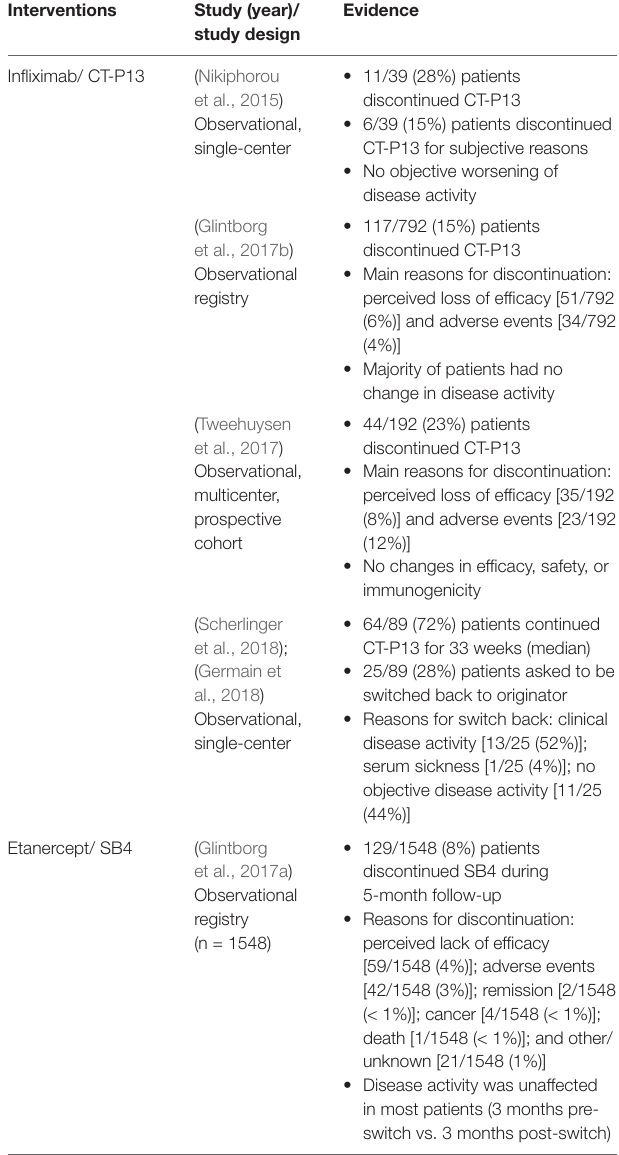
TABLE 1 | A summary of evidence supporting nocebo effects in biosimilar switching studies in patients with rheumatic disease. Adapted from